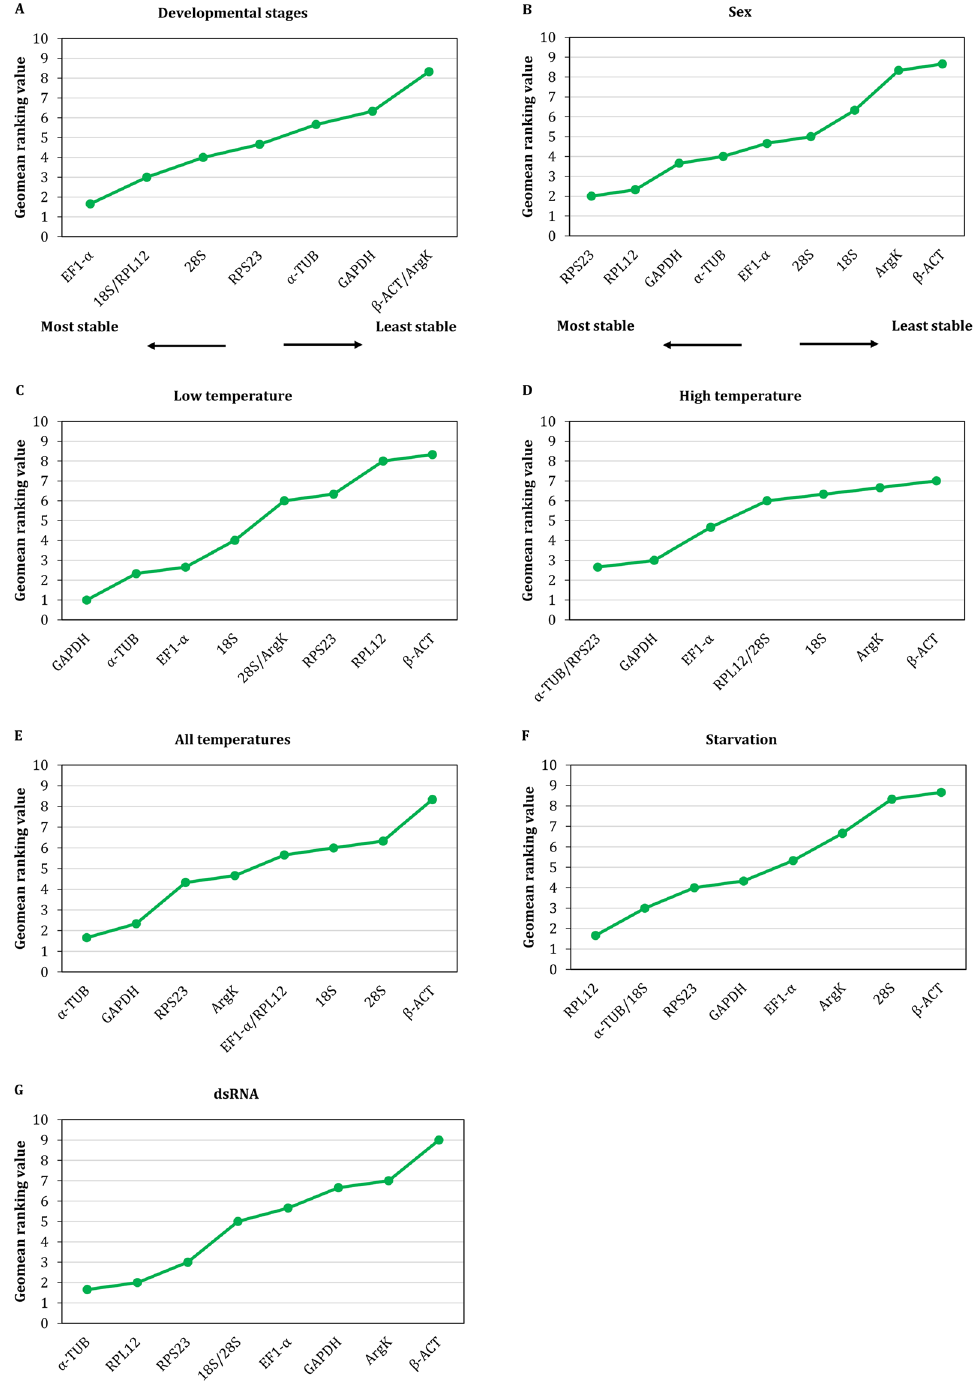
Figure 2. Comprehensive stability ranking of candidate reference genes based on BestKeeper, geNorm and NormFinder